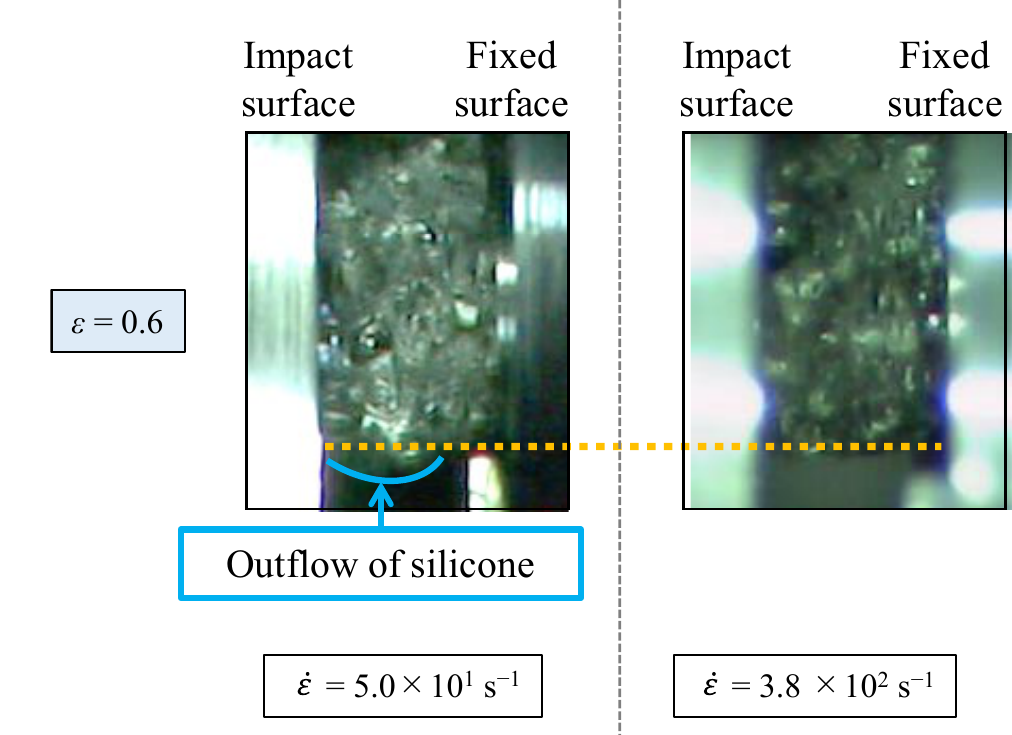
Figure 11. Deformation of Ni/silicone foam at strain of 0.6 for strain rates of 5.0 × 10 1 and 3.8 × 10 2 s − 1 .